Question: How would you classify this visualization?
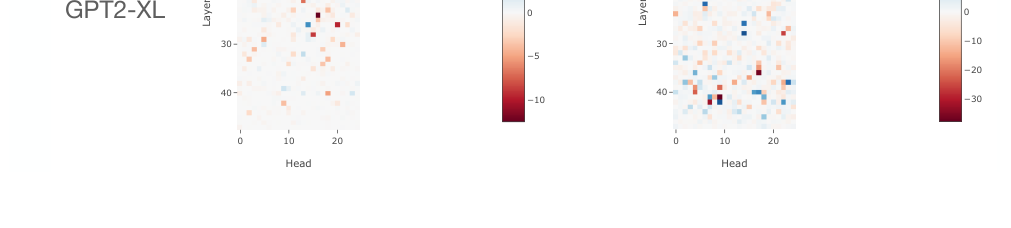
Answer: bar